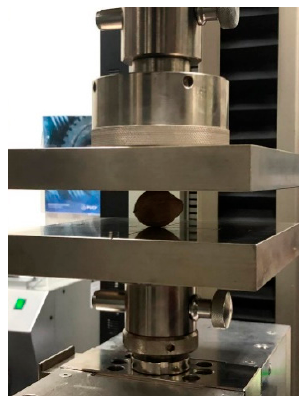
Figure 3. Fruit compression test set-up.